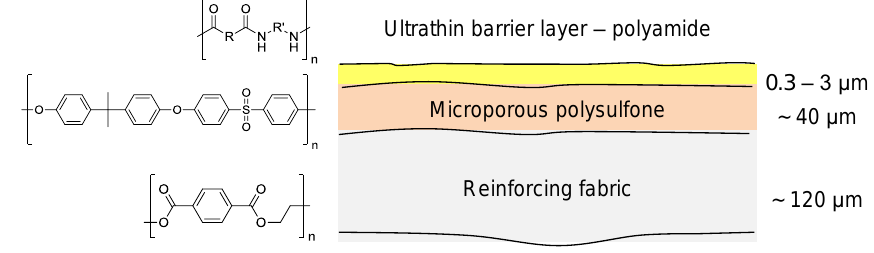
Figure 8. Structure of a typical TFC membrane for NF or RO.